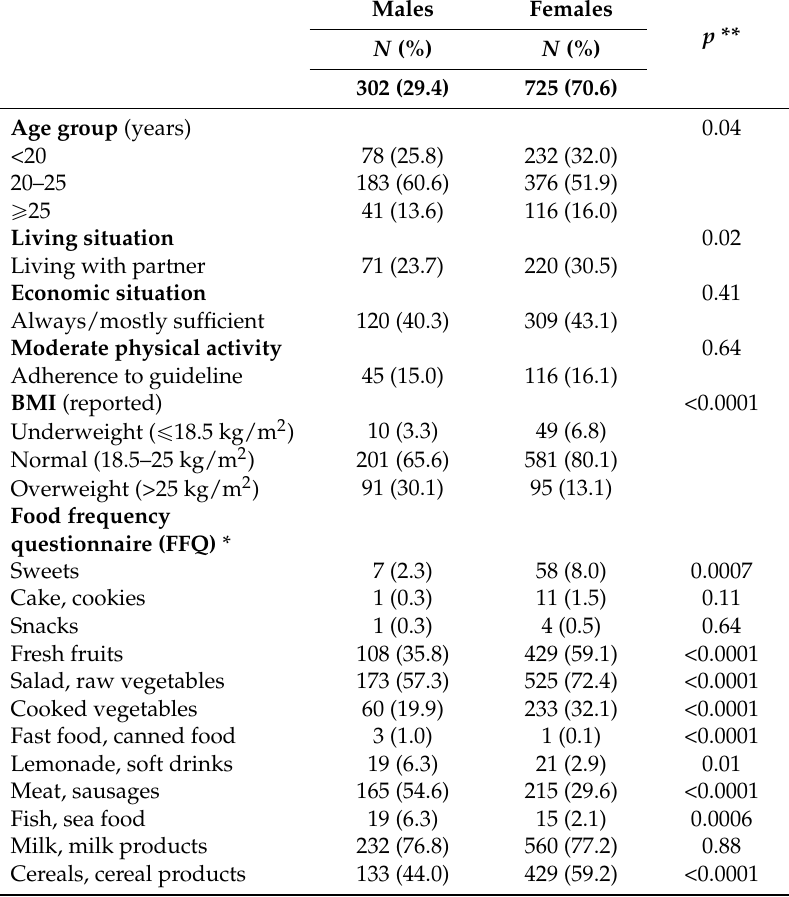
Table 1. Socio-demographic and lifestyle characteristics and intake of 12 food groups by gender among undergraduates, University of Turku, Finland,